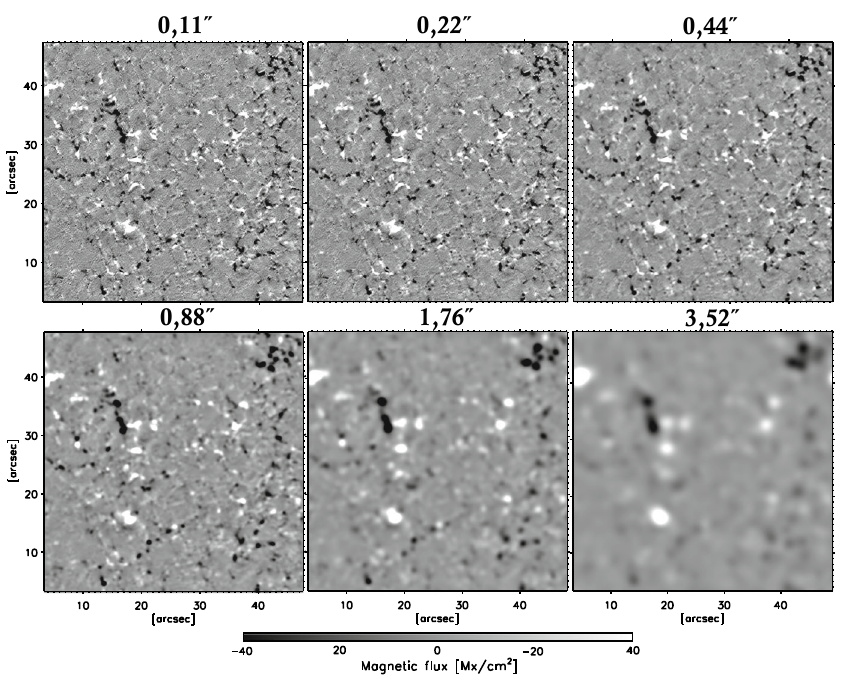
Fig. 25 Effects of spatial degradation on magnetograms generated from SUNRISE/IMaX V5-6 data using theweakfieldapproximation.Thetopleftpanelisthelongitudinalfluxdensitymapattheoriginalresolution of IMaX. The other panels show the maps corresponding to different resolutions. The gray scale is the same in all panels. Note that the spatial degradation is applied to the observed Stokes profiles and not to the magnetograms themselves